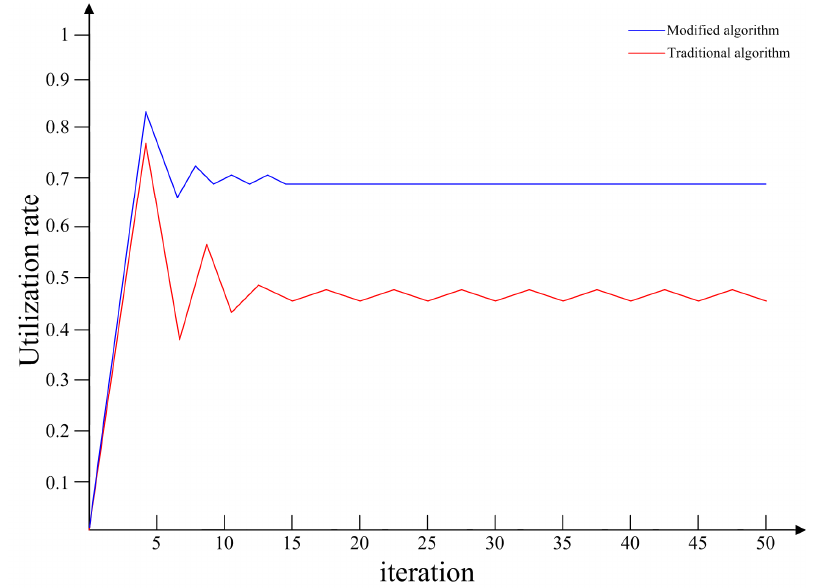
Figure 10. Utilization rate of free channels between two